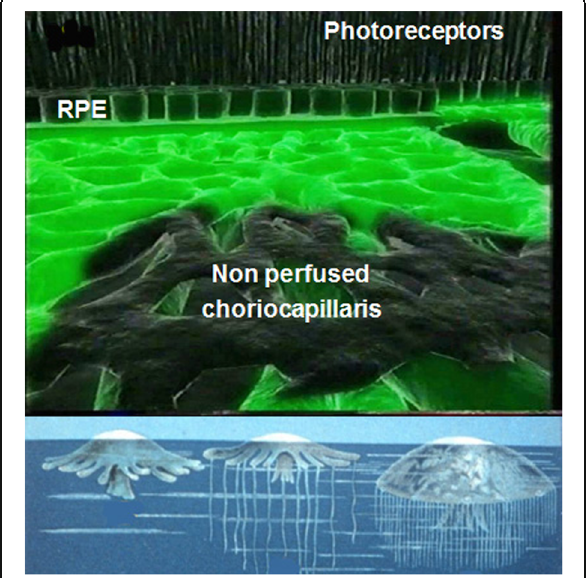
Fig. 5 The jellyfish analogy for choriocapillaritis. The lesion process (non-perfused choriocapillaris – top picture) lies immediately under the RPE in the same manner as jellyfishes are lingering under the surface of the water (lower